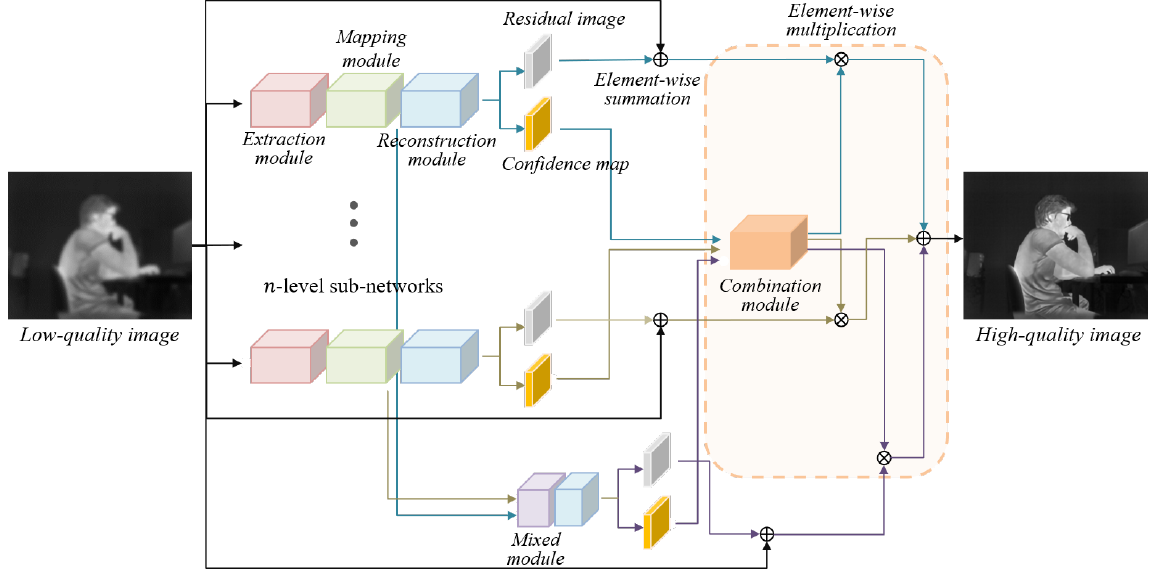
Figure 1. The structure of our proposed